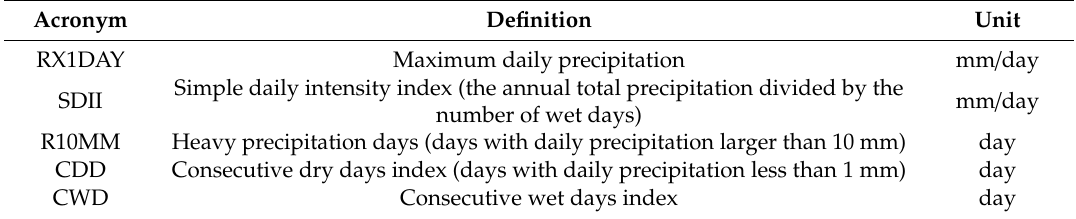
Table 1. Precipitation extreme indicators used in this